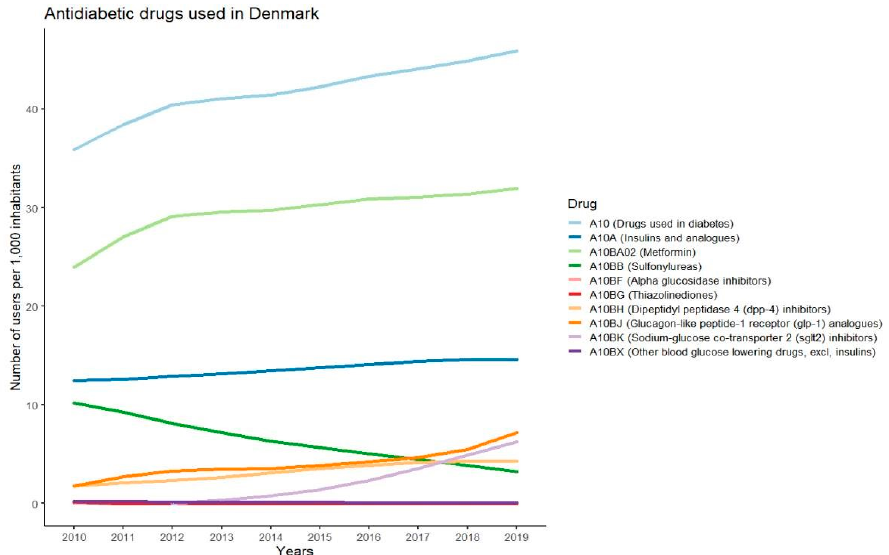
Figure 1. Graphs showing number of users per 1000 inhabitants in Denmark for different antidiabetic drugs in the years 2010–2019.